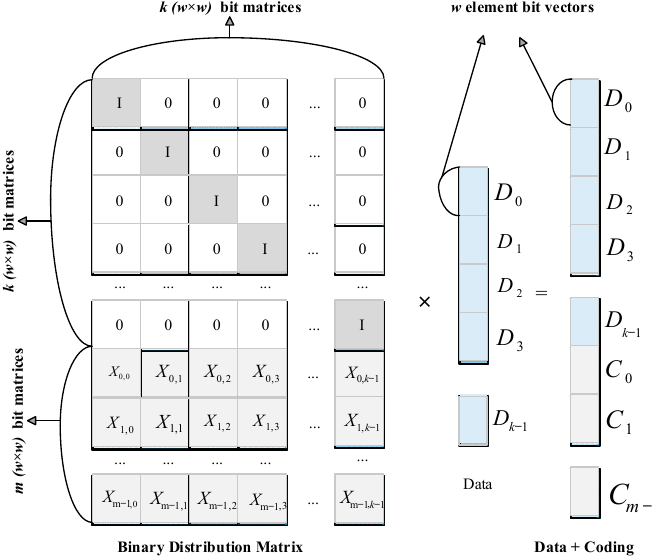
Figure 2. The encoding process is illustrated by the bit matrix–vector dot